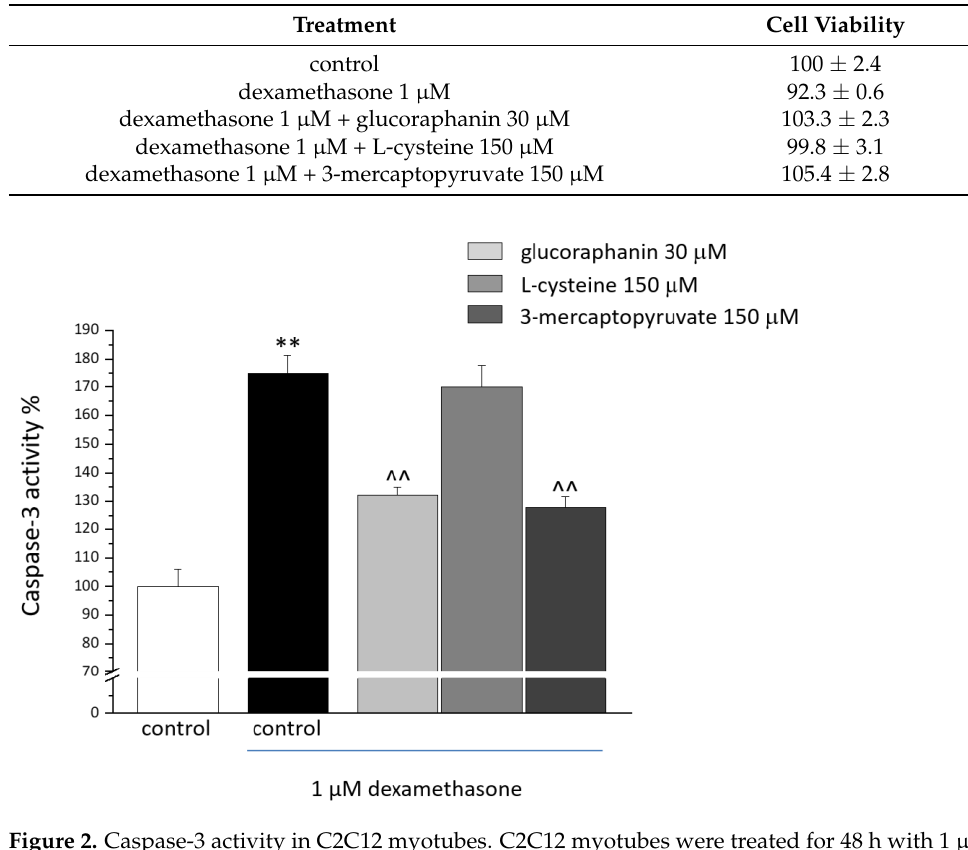
Figure 2. Caspase-3 activity in C2C12 myotubes. C2C12 myotubes were treated for 48 h with 1